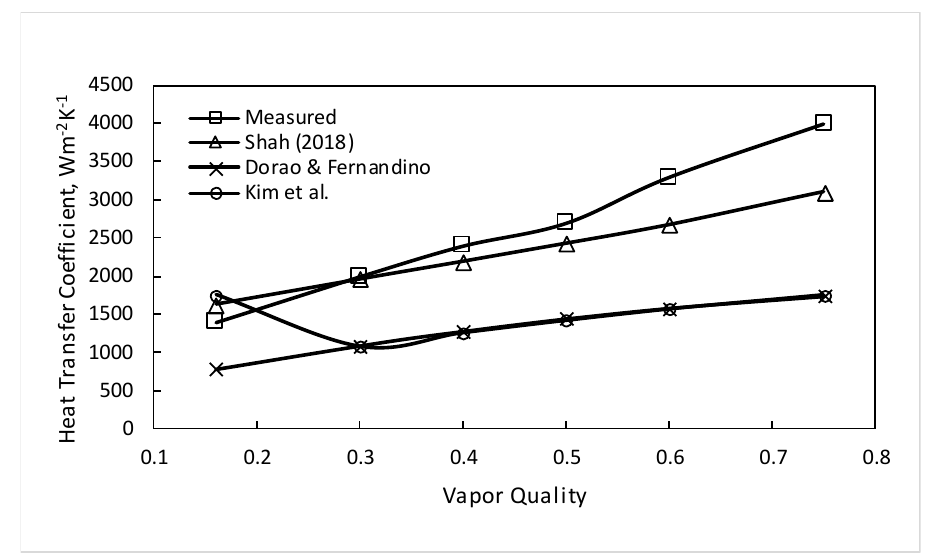
Figure 4. Data of Derby et al. for a triangular channel compared to various correlations. T SAT = 35 C, G = 75 kgm −2 s −1 , We GT = 19.